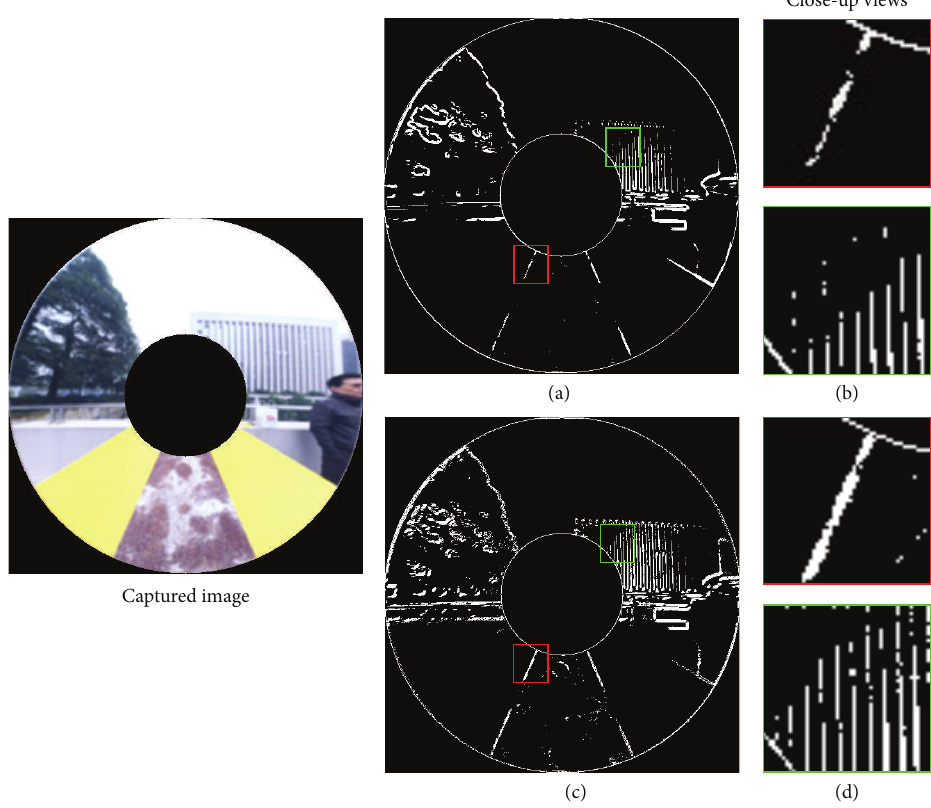
Figure 7: Gradient computation results of real image: (a) and (b) are traditional gradient computation result and close-up views, respectively; (c) and (d) are omnigradient computation result and close-up views,